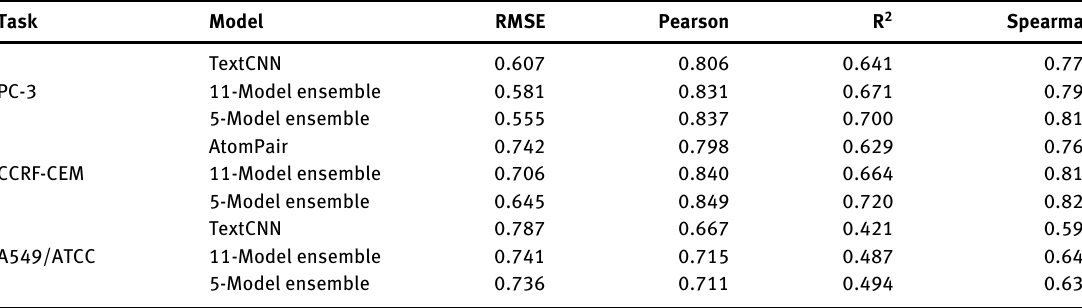
Table 3: Ensemble results for regression